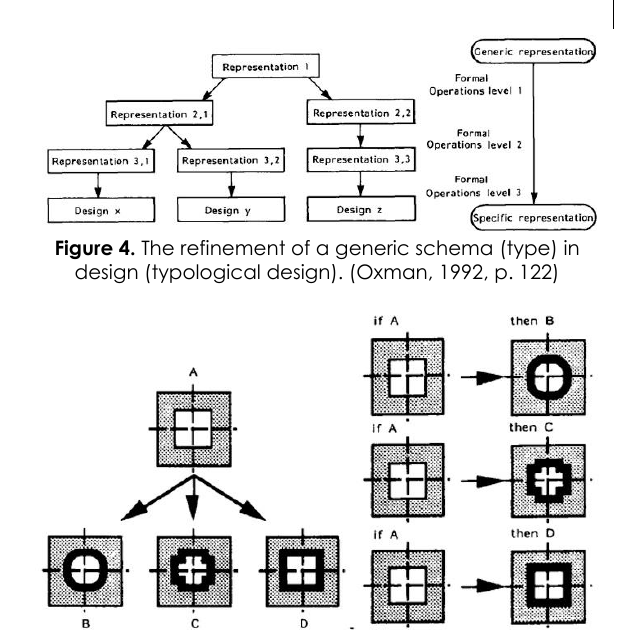
Figure 5. An example to the refinement process. (Oxman, 1992, p.